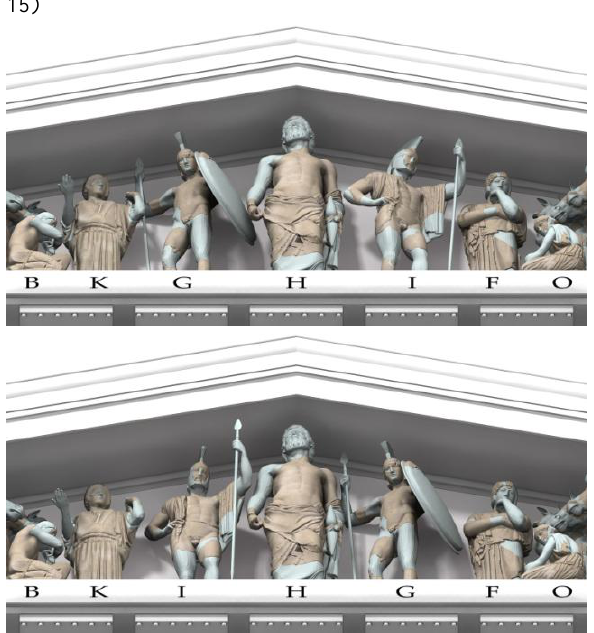
Figure 14 The central figures of the pediment from the